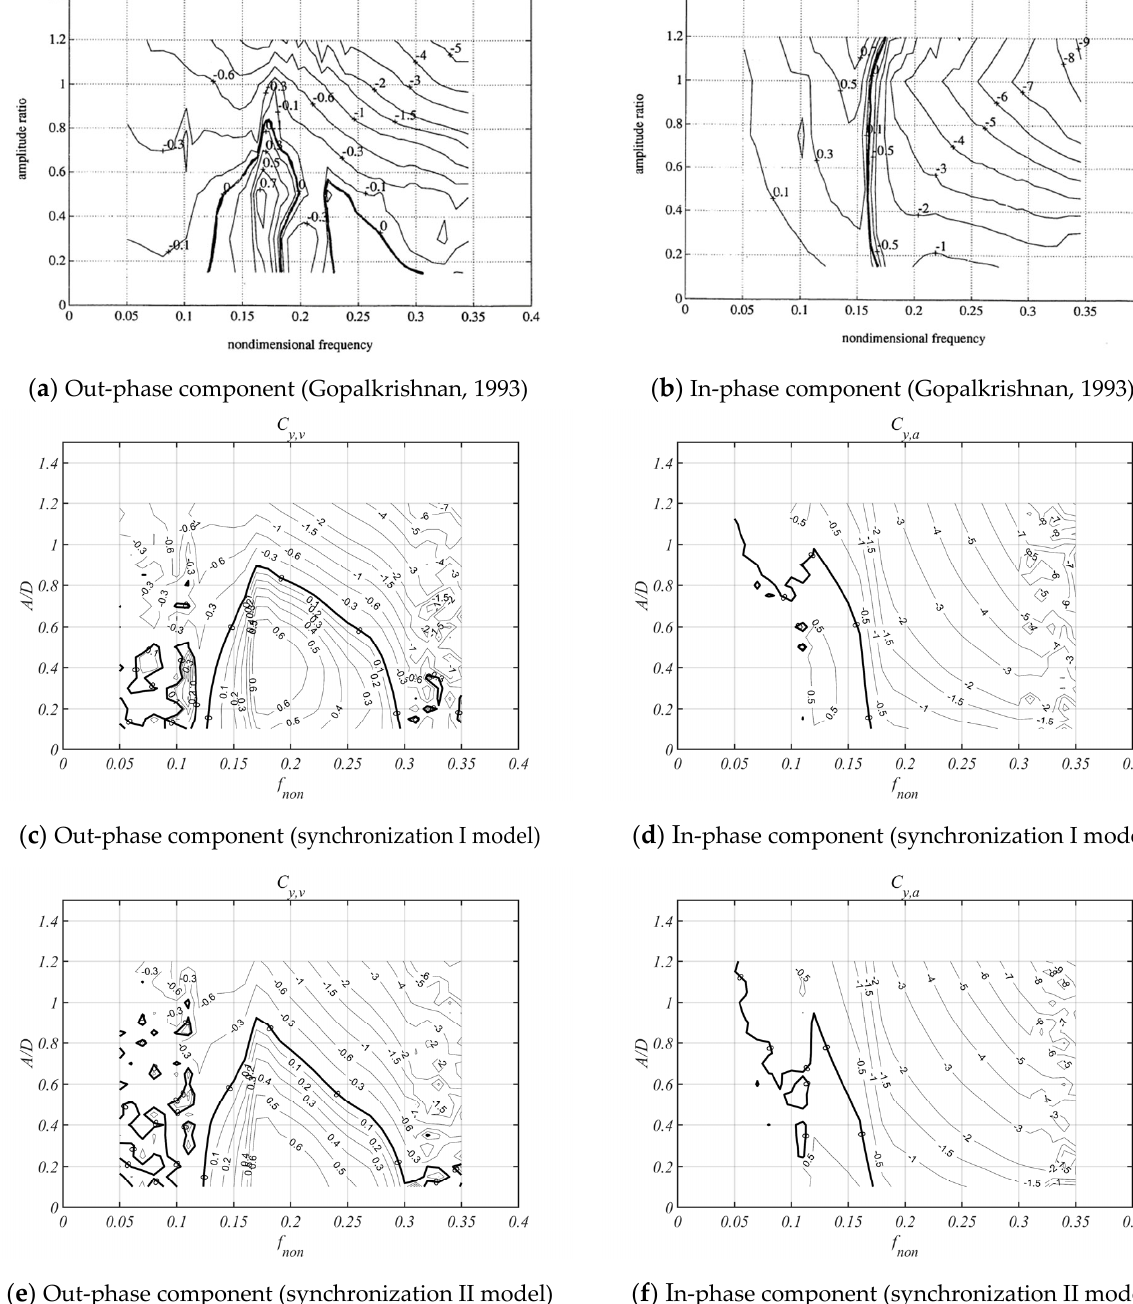
Figure 7. Force coefficients of forced oscillations.